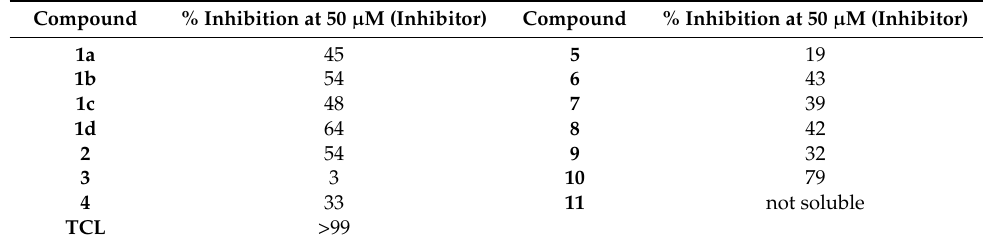
Table 6. Enzyme inhibition values for the INH derivatives. Results are expressed as a percentage of InhA